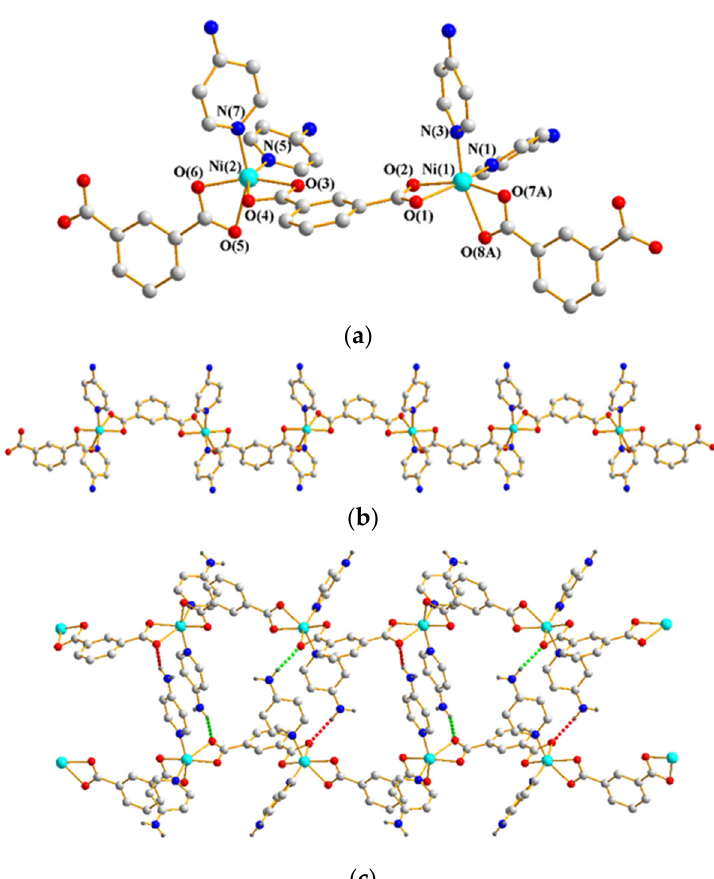
Figure 2. ( a ) Coordination environment of Ni(II) ion in 2 . Symmetry transformations used to generate equivalent atoms: (A) x, − 1 + y, z. (b) The Ni(II) ions are linked by 1,3-BDC 2 − ligands to form a 1D concave–convex chain. ( c ) The chains are linked by the N-H—O hydrogen bonds.